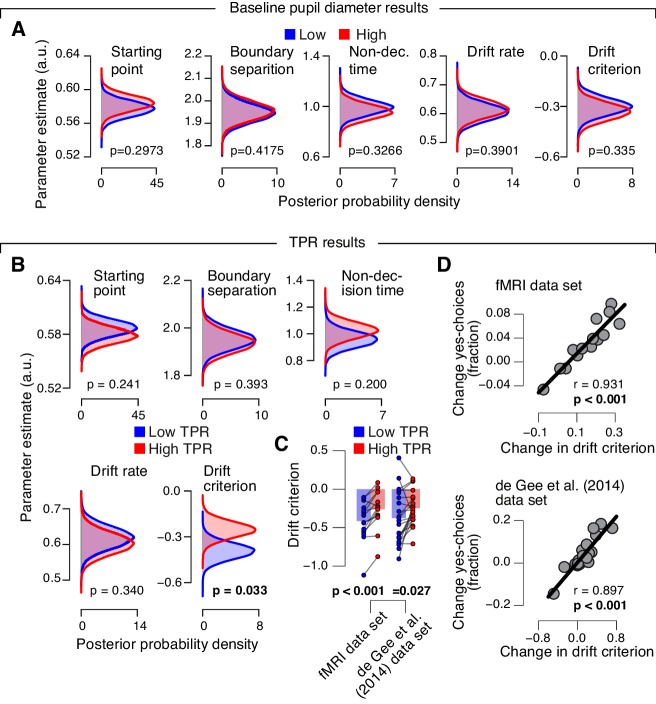
Phasic arousal predicts reduction of accumulation bias.(A) As main Figure 4C, but now after splitting trials by baseline pupil diameter, quantified as the mean pupil size in the 0.5 s before decision interval onset. (B–D) As main Figure 4C–E, but now without removing trial-to-trial variations from TPR due to reaction time (RT). The pattern of results is qualitatively identical. Data points, individual subjects; stats, permutation test.